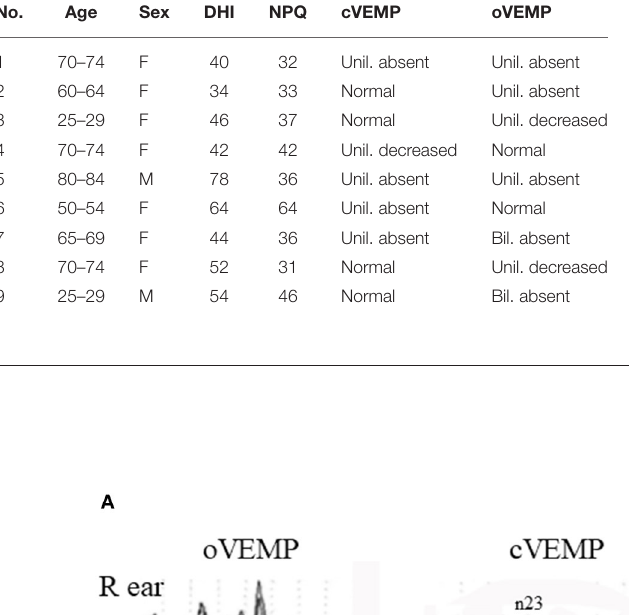
Frontiers in Neurology |